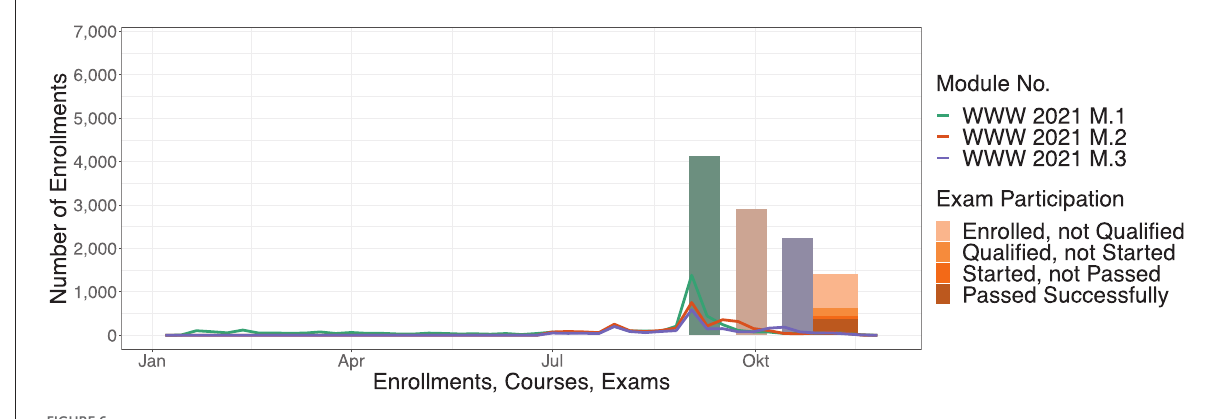
FIGURE6 WWW 2021 with the exam opportunity and the required modules. The lines show the weekly enrollments. The first three bars show the original course periods and the total enrollments in each of the course modules. The orange bar show the final exam period.